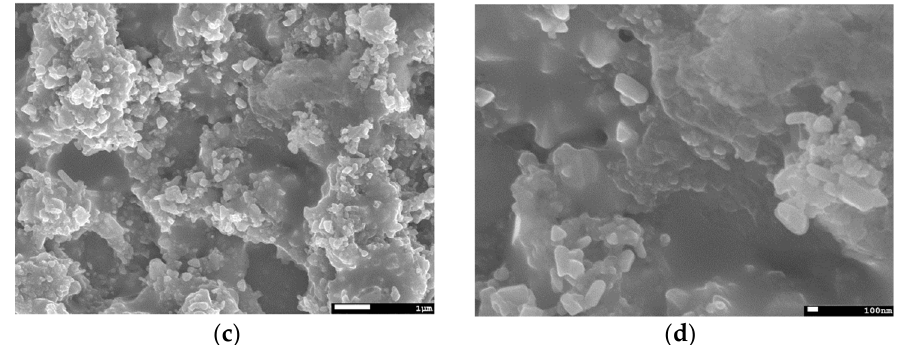
Figure A1. Scanning electron microscopy (SEM) top view image series of a CuInSe 2 (CISe)‐film from Cu‐In + Se precursor after face‐to‐face annealing at 550 °C for 5 min with 46.1 kN/m² at different magnifications, ( a ) 200×; ( b ) 2,000×; ( c ) 10,000×; ( d ) 30,000×.